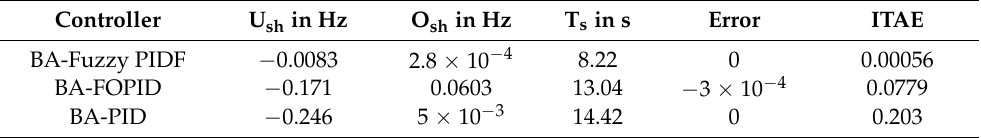
Figure 16. Comparison of three controllers tuned by BA based on ITAE for LFC of the GB system in scenario 2 with 0.053 pu load disturbance.